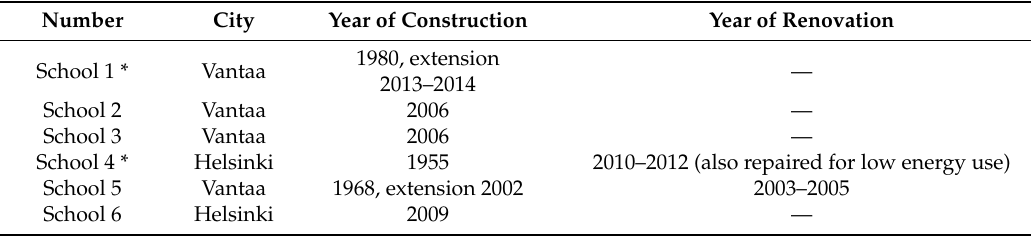
Table 1. Information about the studied school buildings.